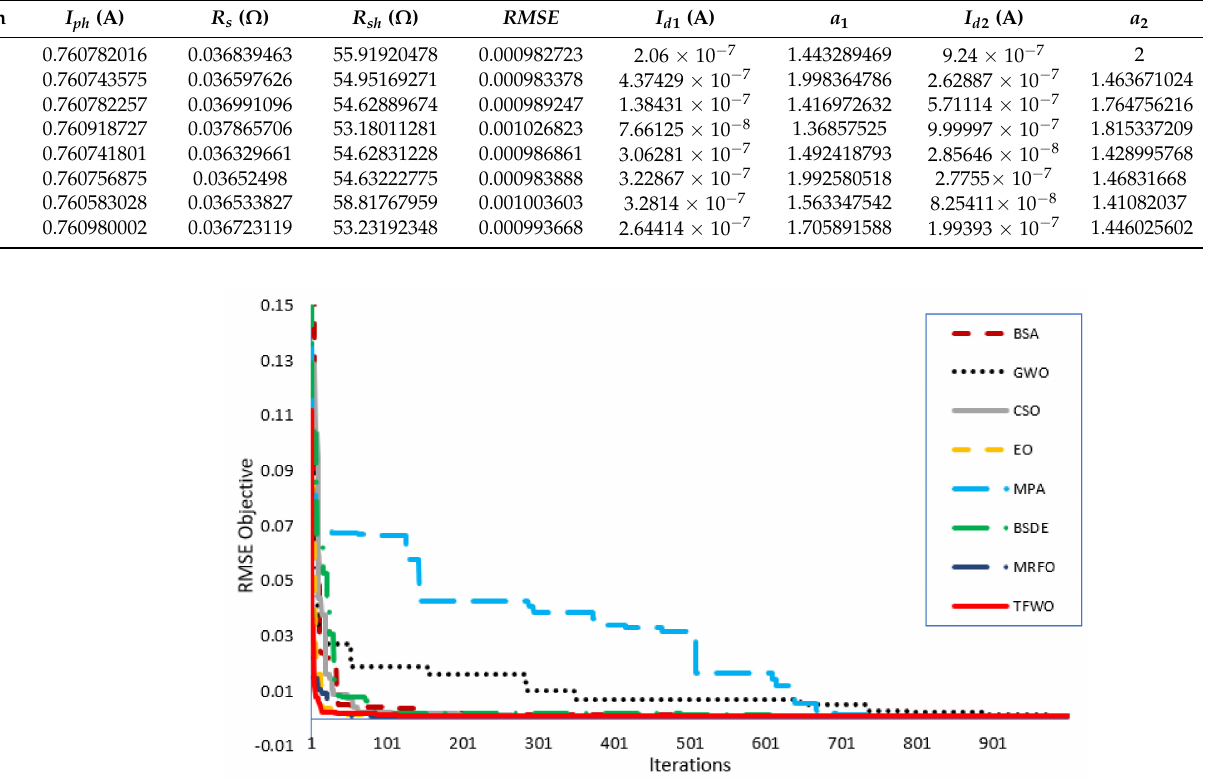
Table 5. The parameters extracted for R.T.C. France DDM.